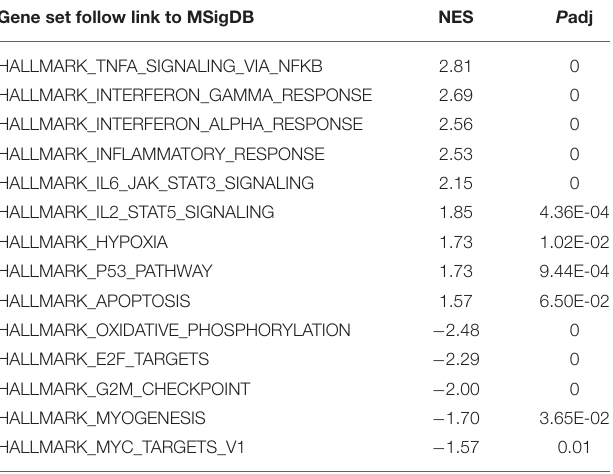
FIGURE 1 | Differential expression of data between two sets of samples. (A) Gene expression values boxplot of each sample after normalization using DESeq method; (B) Sample to sample distance heatmap of all samples in Cov and Mock group; (C) MA plot of genes (The blue points represent genes screened based on |fold change| > 2 and a corrected P adj of < 0.01). TABLE 1 | The most significant gene sets of Cov vs. Mock in gene set enrichment analysis (GSEA). Gene set follow link to